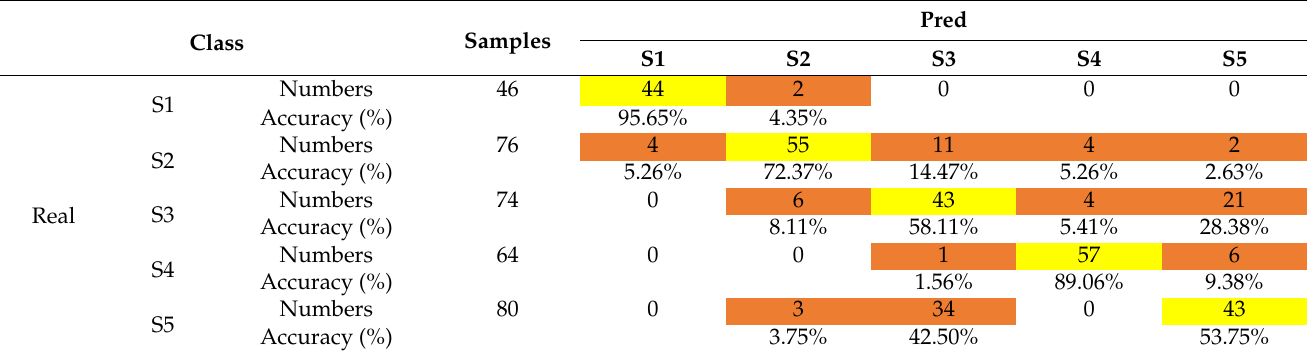
Table 2. The performance of the Group 1.